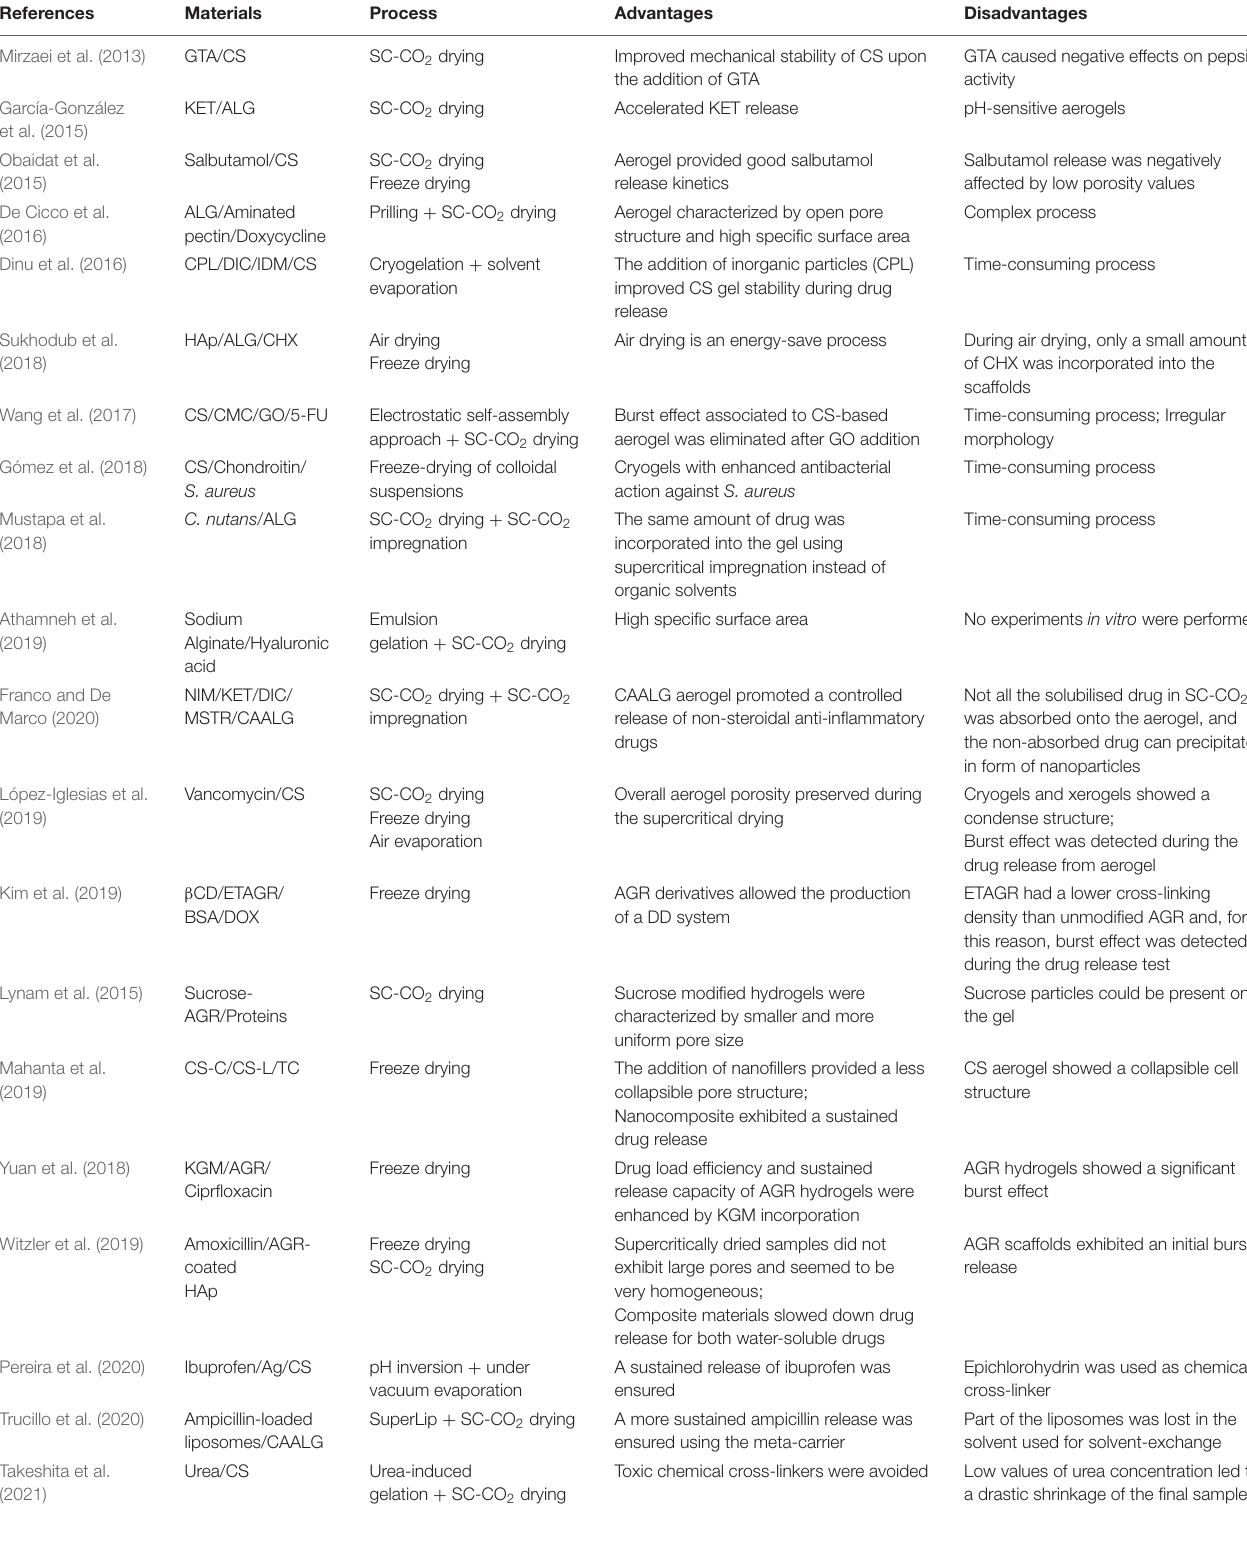
TABLE 1 | Gels of agarose, alginate and chitosan, applied in drug